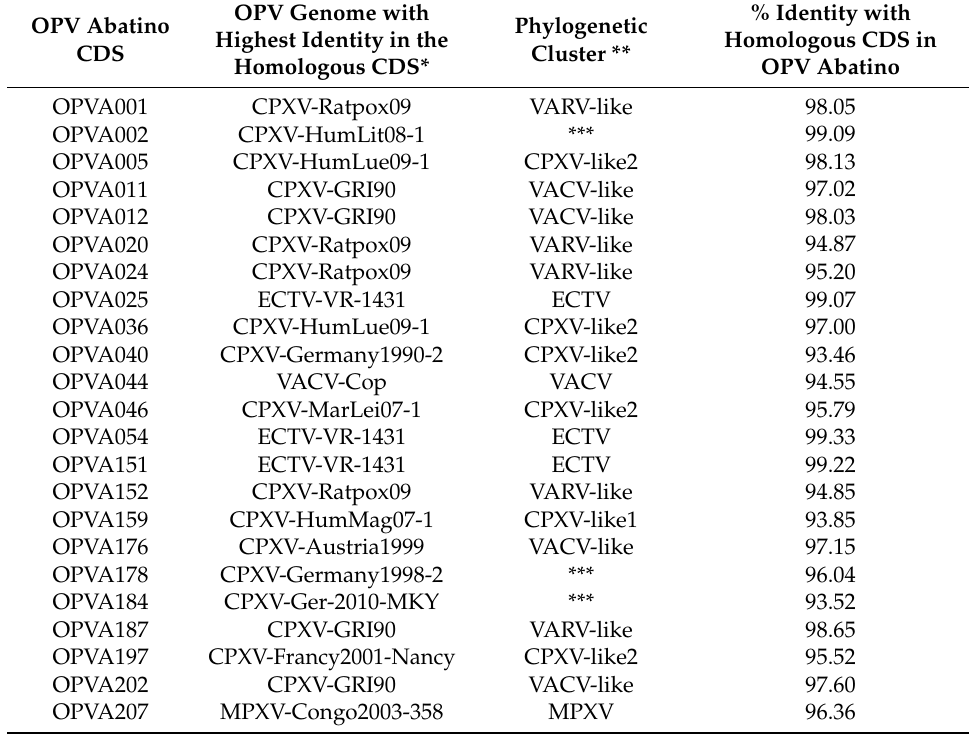
Table 1. OPV genomes showing the highest identity with OPV Abatino in the CDS showing no or low homology with the reference ECTV or CPXV. For the 23 CDS showing either no homologous ( n = 5), or low similarity (<90%, n = 6) respect of both ECTV-Mos and CPXV-Ger2010-MKY reference strains, or no homologous CDS in one reference genome and less than 90% similarity with the other one ( n = 12) a BLASTn identity analysis was performed with all OPVs included in the phylogenetic analysis (Figure 2). For each of the 23 CDS, the OPV genome with the highest identity (first hit in BLASTn analysis) is shown, together with its phylogenetic cluster. % Identity with OPV Genome with Phylogenetic OPV Abatino Homologous CDS Highest Identity in the Cluster ** Homologous CDS*